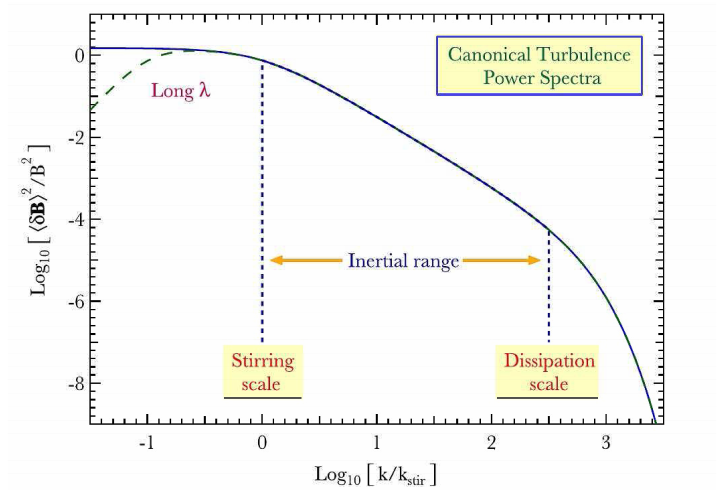
Figure 3. Sketch of a magneto-hydrodynamic turbulence spectrum plausibly expected in the post-shock region. Waves are excited at the longest wavelengths corresponding to the stirring scale, and cascade down to smaller scales, down to the dissipation scale. From